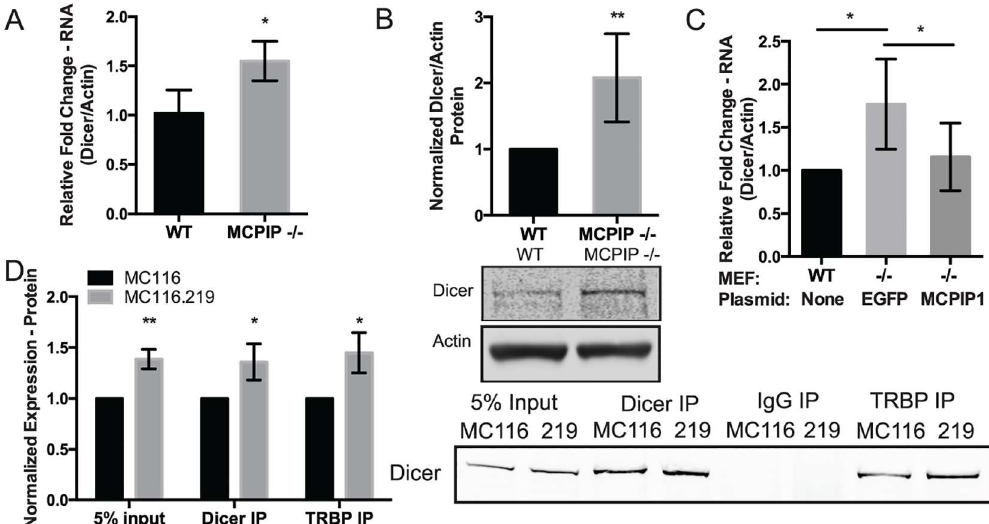
Fig 6. Repression of MCPIP1 increasesDicer expression and TRBP association. (A) RNA from WT and MCPIP1 -/- MEFs were analyzedfor Dicer expressionusing qPCR. Results are shown relative to β -actinand normalized to the WT control. N = 3. (B) WT and MCPIP1 -/- MEF protein lysates were evaluatedfor Dicer using western blot analysis. β -actinwas used as a loadingcontrol. The results are averagedfor six replicates, and a representative western blot is shown. (C) WT and MCPIP1 -/- MEFs were transfected with a MCPIP1 expression vector or an EGFP negative control vector, and RNA was isolated 48 hpt. RNA was DNase treated and analyzedfor Dicer expressionusing qPCR. Results are shown relative to β -actinand normalized to the WT control, N = 4. (D) MC116 and KSHV infected MC116.219 cells were immunoprecipitatedwith anti-Dicerand anti-TRBP antibodies and blotted for Dicer. The results are averaged for four replicates and a representative blot is shown. For all graphs, results are shown as mean ± SD. Significancewas assessedusing a Student’s t test, * p (cid:20) 0.05, ** p (cid:20) 0.01. Numericaldata can be found in S1